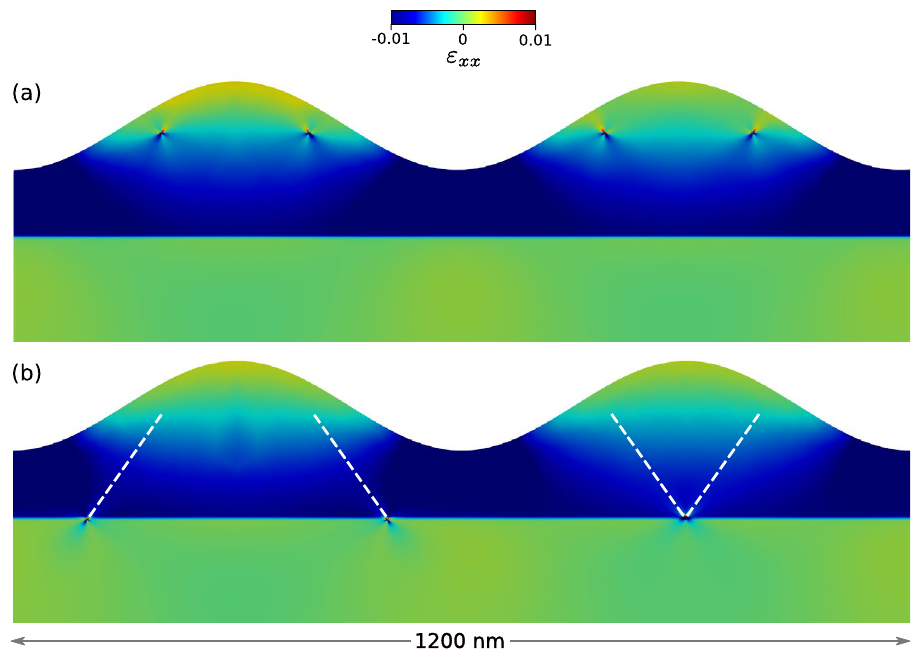
Figure 6. Initial ( a ) and final ( b ) configuration in a 2D Dislocation Dynamics simulation obtained using forces from NN functions. Dislocation paths on their glide planes are reported as dashed white lines. A sessile edge dislocation is formed in the middle of the simulation